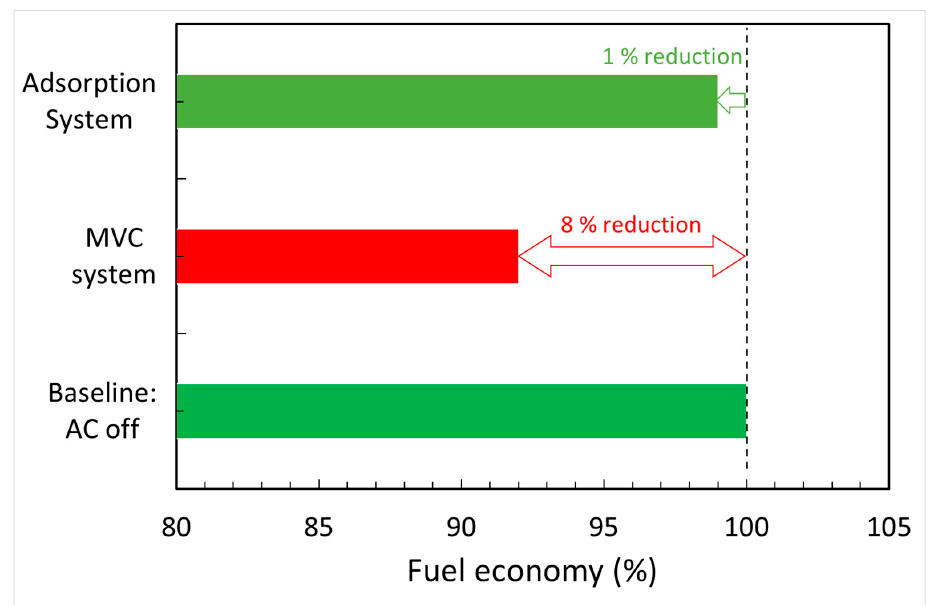
Figure 8. Comparison of fuel consumption with the current system.